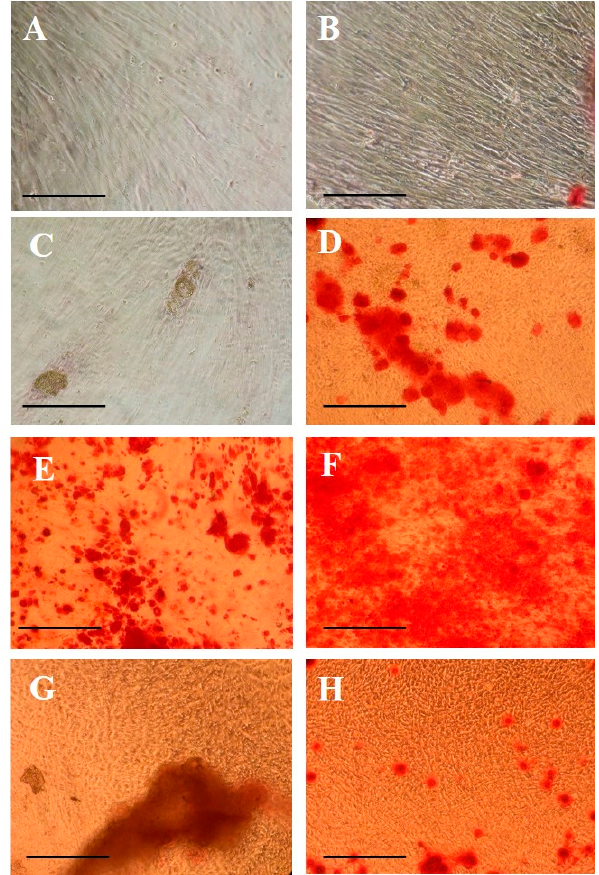
Figure 3. Alizarin Red S staining results in hPCs after 14 and 20 days of culture. ( A , B ) Control hPCs at 14 and 20 days; ( C , D ) hPCs in contact with PLGA-Fisiograft at 14 and 20 days; ( E , F ) hPCs in contact with PLGA/HA-Alos at 14 and 20 days; ( G , H ) hPCs in contact with PARASORB Sombrero at 14 and 20 days. All images are at 10× magnification. The scale bars are equivalent to 50 μ m.